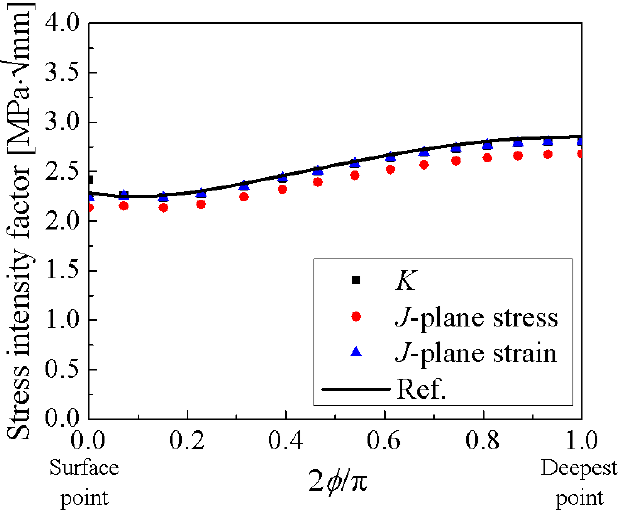
Figure 4. Comparison of SIF according to calculation methods [22].